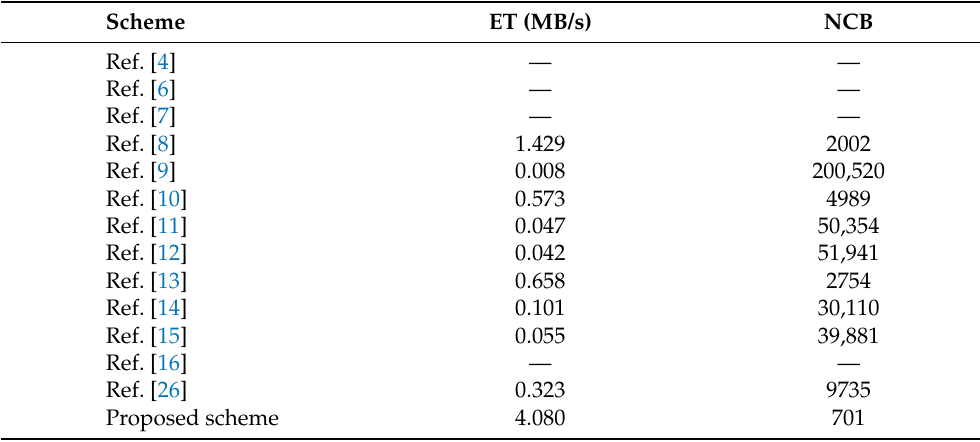
Table 12. Comparison with existing schemes based on time